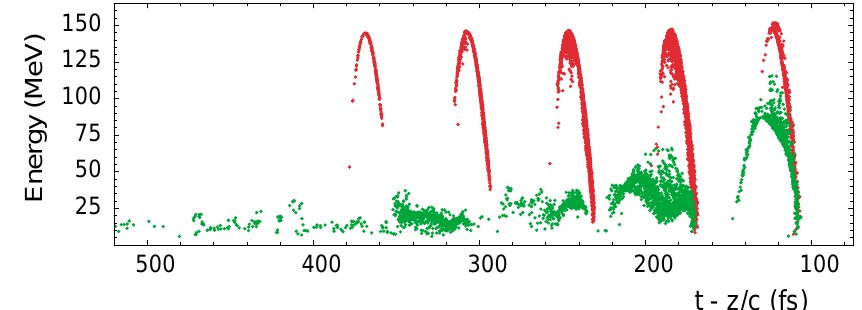
FIG. 6. (Color) Snapshot of energy vs t 2 z (cid:3) c at 2.0 mm for a 2 nC bunch (green) and test particle bunch (red).